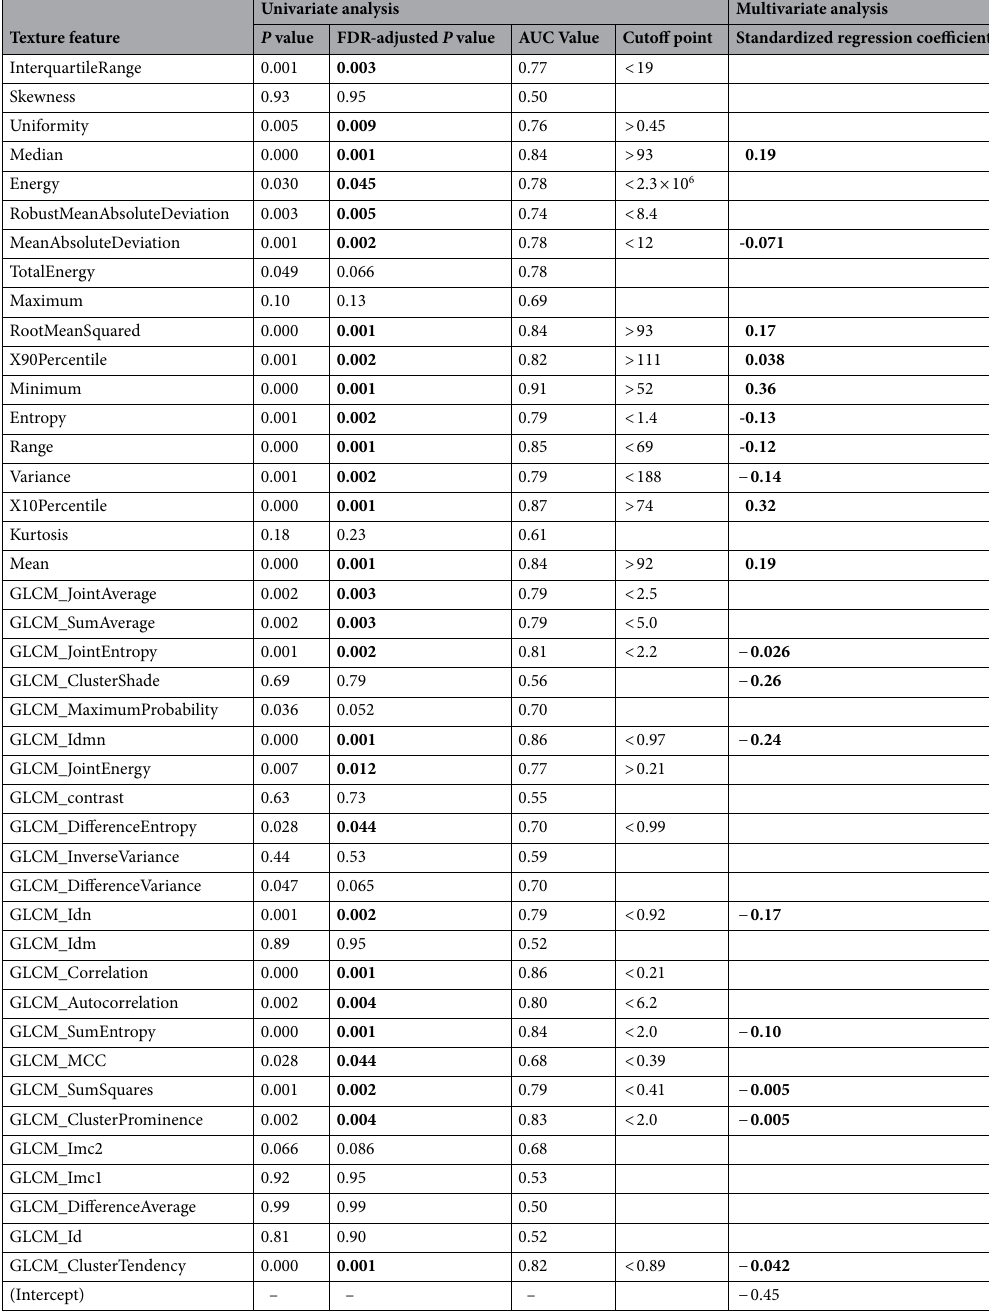
Table 2. Texture features differentiating olfactory neuroblastoma from squamous cell carcinoma in univariate and multivariate analysis. FDR false discovery rate; AUC indicates area under the curve. Significant FDR- adjusted P values < 0.05 and non-zero standardized coefficients of the elastic net logistic regression are in